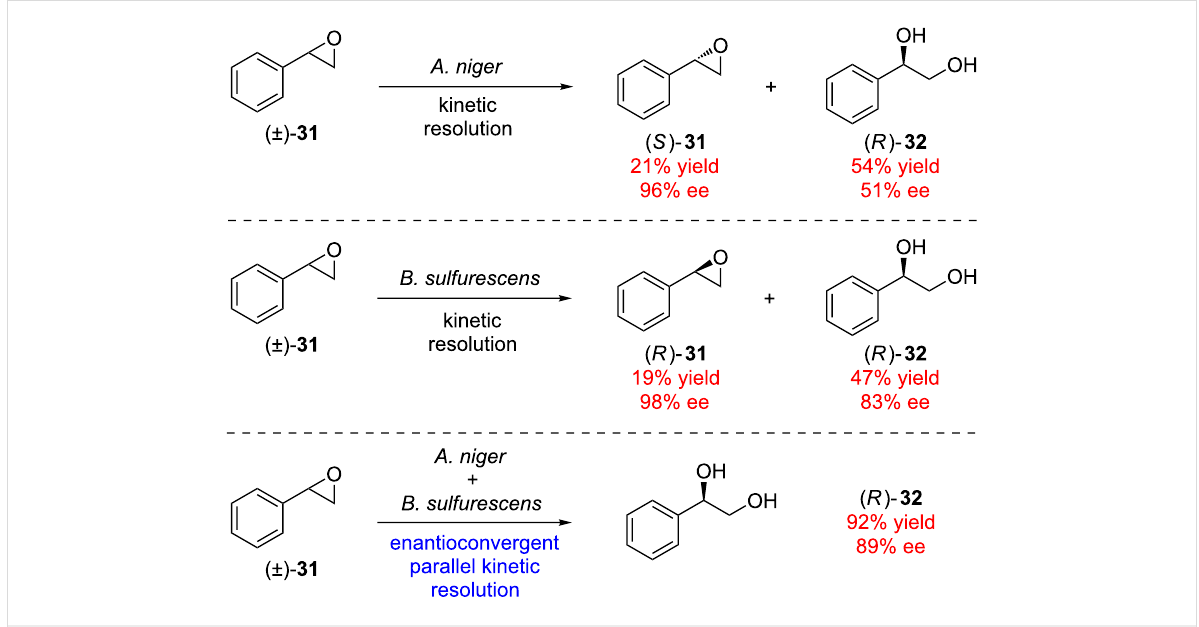
Scheme 7: Enantioconvergent parallel kinetic resolution by two complementary biocatalysts.